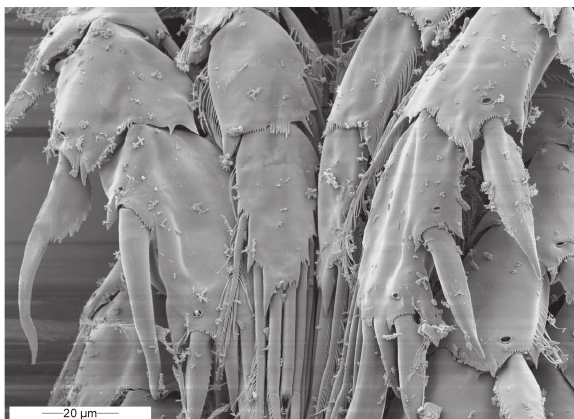
Fig . 2. – scanning electron micrograph of second pair of swimming legs of male P. xiphophorus from lake faro, showing asymmetry in form of spine on outer margin of second exopodal segment. anterior view, showing spine modified on right side but unmodified on